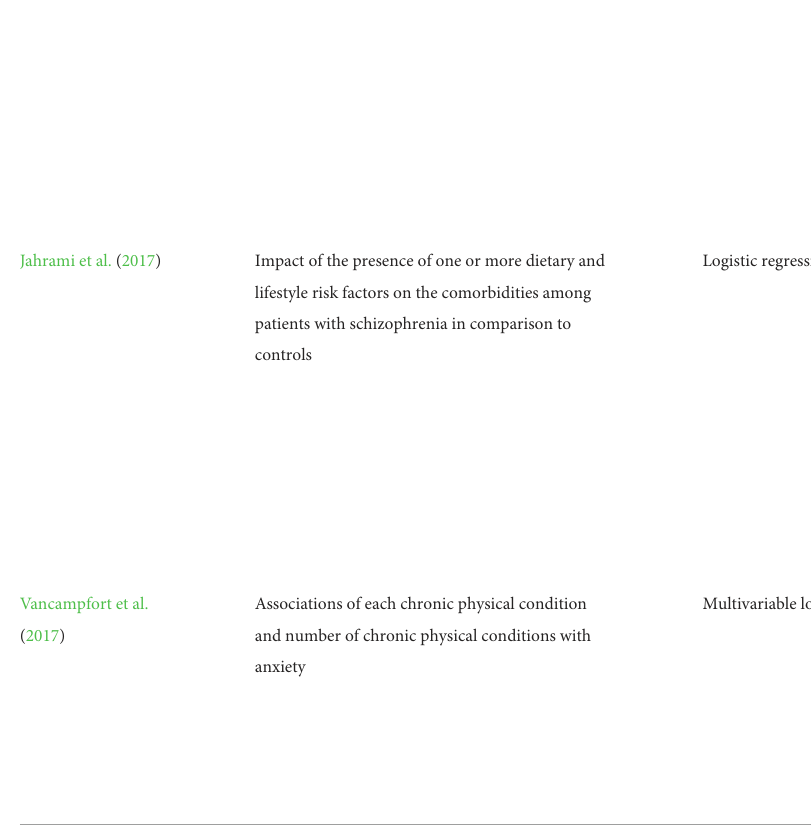
Schizophrenia vs.